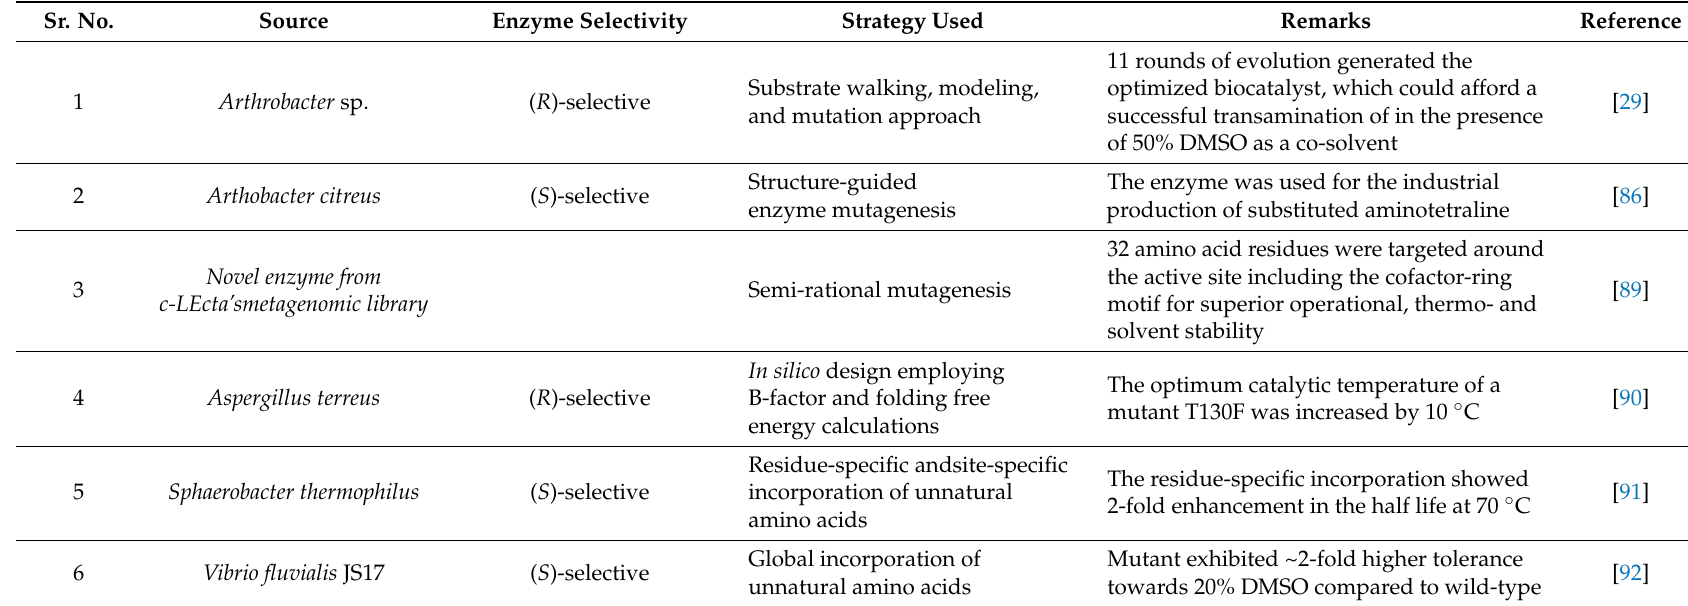
Table 2. Selected examples of application of protein engineering techniques to improve operational stability of ω -TAs. Sr.